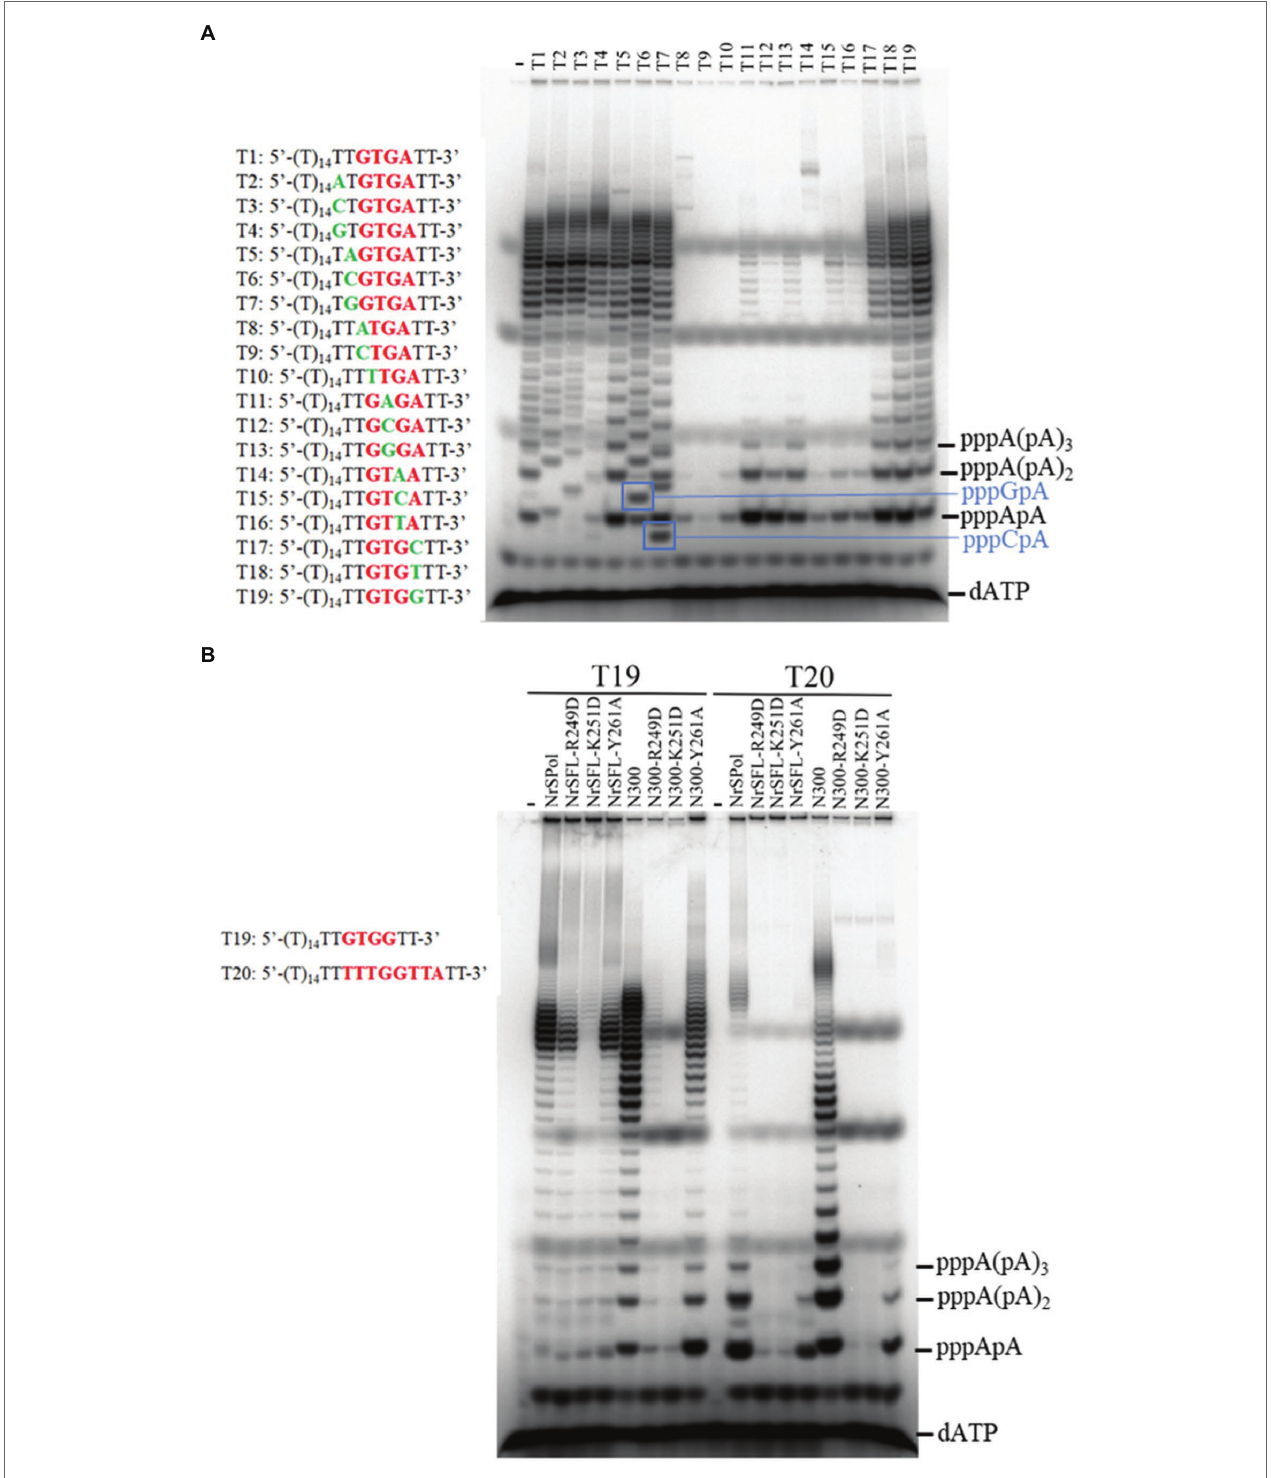
FIGURE 5 | Identification of an efficient primase recognition site. (A) Dissection of the recognition sequence. Reactions contained 10 μ M various oligodeoxynucleotide templates, 50 μ M dNTPs, trace amounts of [ α - 32 P] dATP, and 500 nM N300 and were incubated for 30 min at 50 ° C. (B) Comparison of the primer synthesis activity of NrSPol, N300, and their mutants on templates containing recognition sequences 5 ' -GTGG-3 ' and 5 ' -TTTGGTTA-3 ' . The reactions contained 10 μ M template, 50 μ M dATP, trace amounts of [ α - 32 P] dATP, and 500 nM NrSPol, N300, or their mutants. After incubation for 30 min at 50 ° C, the products were separated on a 3 M urea-25%